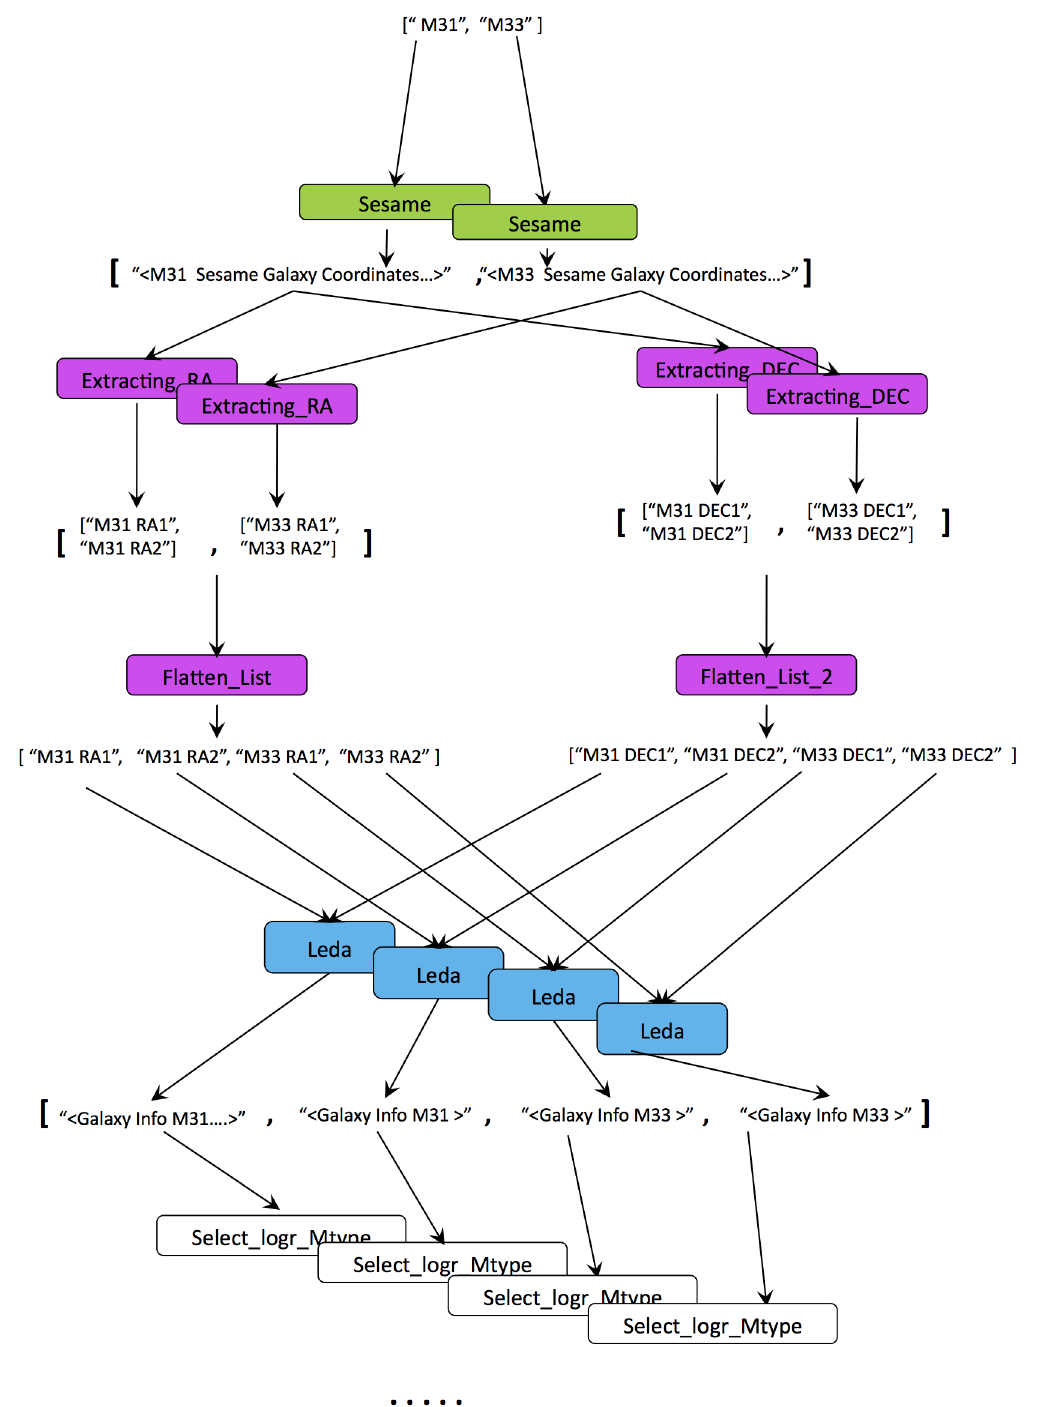
Figure 2. A fragment of execution illustrated for the Astronomy